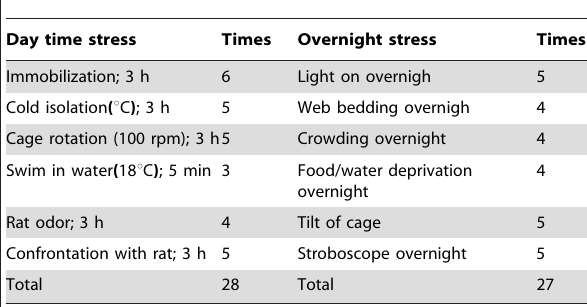
Table 1. Protocol of chronic unpredictable